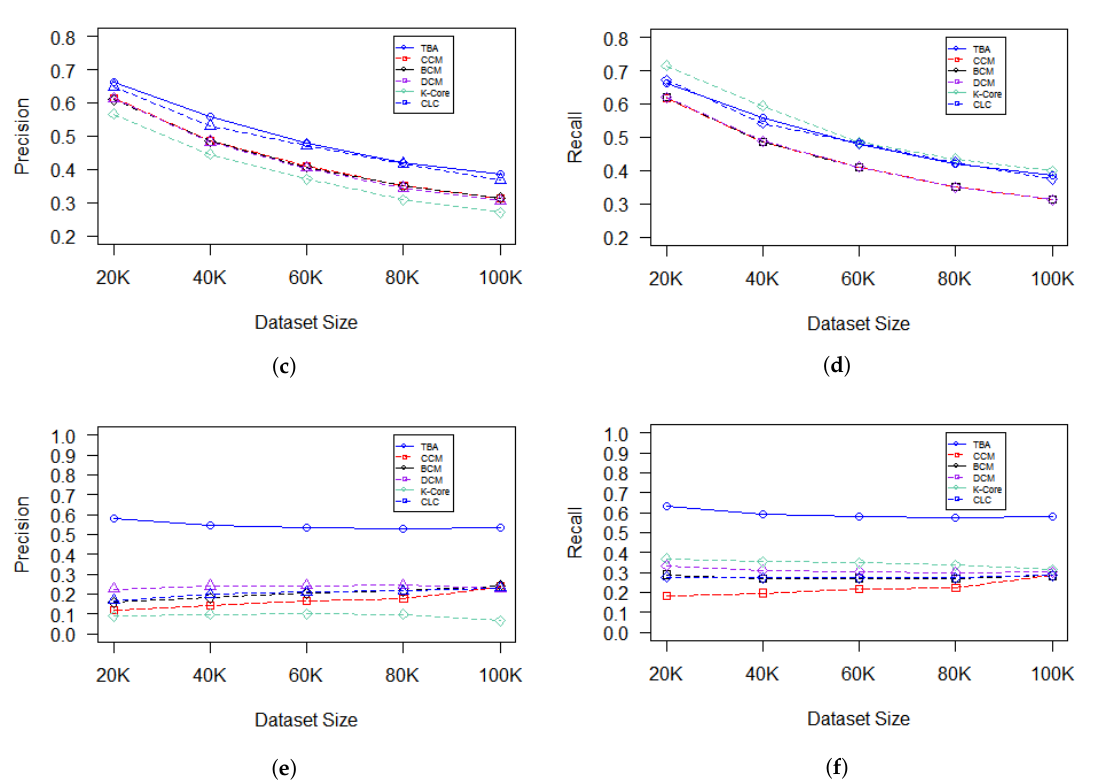
Figure 8. Performance comparison in terms of precision and recall for each dataset. ( a ) BrightKite precision; ( b ) BrightKite recall; ( c ) Weeplaces precision; ( d ) Weeplaces recall; ( e ) Gowalla precision; ( f ) Gowalla